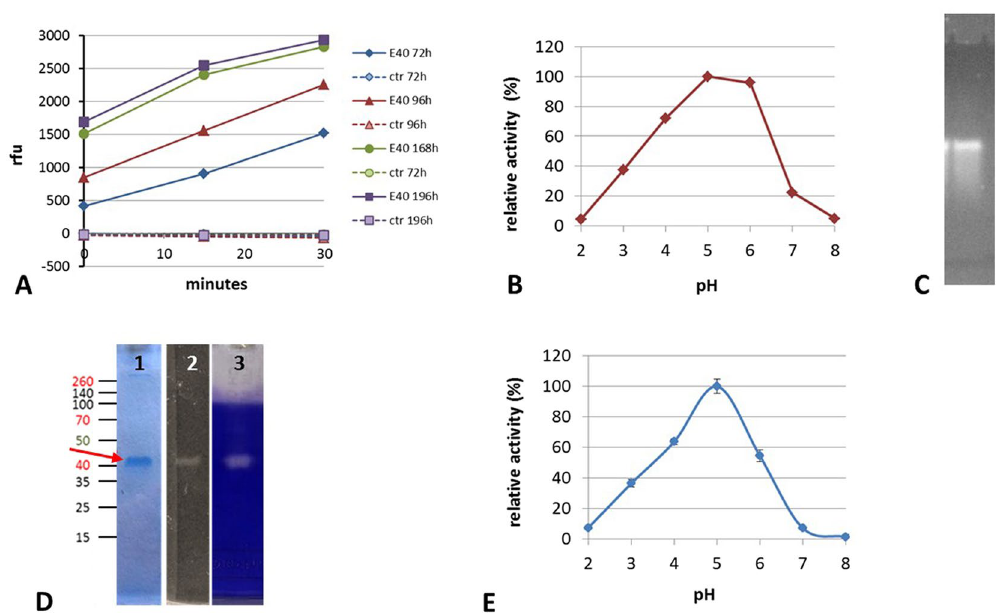
Figure 3. Expression of E40 as active secreted protease by S . lividans TK24/plJ86/e40 submerged fermentation at flask scale (panels (A–C)) or in 15 L bioreactor, with subsequent E40 purification (panels (D and E)). ( A ) Activity of supernatant samples taken at different fermentation times from the producing S . lividans TK24/ plJ86/E40 (E40, continuous line) and absence of activity from the plJ86-empty control strain (ctr, dashed lines). ◆72, ▴ 96, • 168, ◾ 192 fermentation hours. Activity toward the substrate sucAAPF-AMC at pH5 is shown as relative fluorescent units (Y axis) produced in time (X axis). ( B ) Activity showed by the 168 hours supernatant (SN) sample at different pH, showing the optimum at pH5. ( C ) Zymograhy of the 168 h sample at pH5, using the same substrate as in panel (A) and visualized under UV light. ( D ) Profile of purified E40 from the 15 L fermentation, lane 1: final E40 preparation stained with Coomassie (the red arrow indicates E40), lane 2: zymography as in ( C ), lane 3: band of gelatin hydrolysis after 2 hours of digestion at 37 °C and pH5, visualized after Coomassie staining of the gelatin